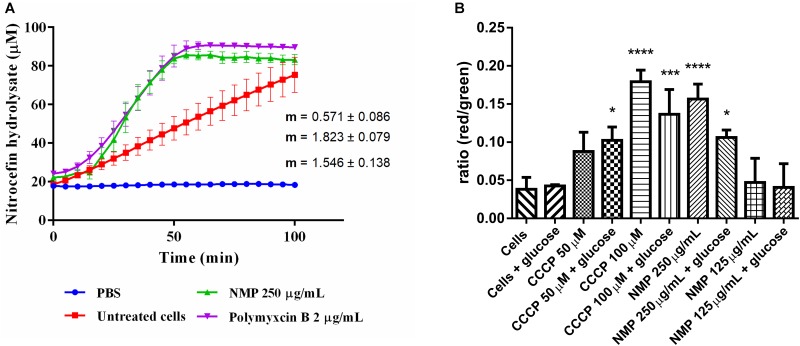
(A) Measurements of β-lactamase enzymatic activity in Klebsiella pneumoniae MGH 78578, in the presence of 250 μg/mL NMP. Activity was measured over 100 min at 37°C. Slope values of the activity curves represent the rate of nitrocefin hydrolysis/min. Polymyxin B was used as an internal control for cell wall disruption at a concentration of 2 μg/mL. Background absorbance values for nitrocefin, nitrocefin with NMP and nitrocefin with polymyxin B were subtracted from the corresponding samples. Slopes and standard deviations were calculated from three individual experiments with two technical replicates each. (B) Effect of NMP on the membrane potential of K. pneumoniae MGH 78578. Bacterial membrane potential was measured by flow cytometry using the Baclight kit (Invitrogen). Bacterial cells were diluted in PBS (control) and in PBS containing defined concentrations of the proton-motive force inhibitor CCCP and NMP in presence and absence of glucose. DiOC2(3) was added to all samples and fluorescence emission data collected in the green and red channels. Variations in the membrane potential cause a change in fluorescence of DiOC2(3) from green to red. Results were compared to the control sample [Cells + DiOC2(3)] by one-way ANOVA statistical test – ∗P < 0.05, ∗∗∗P < 0.001, ∗∗∗∗P < 0.0001.